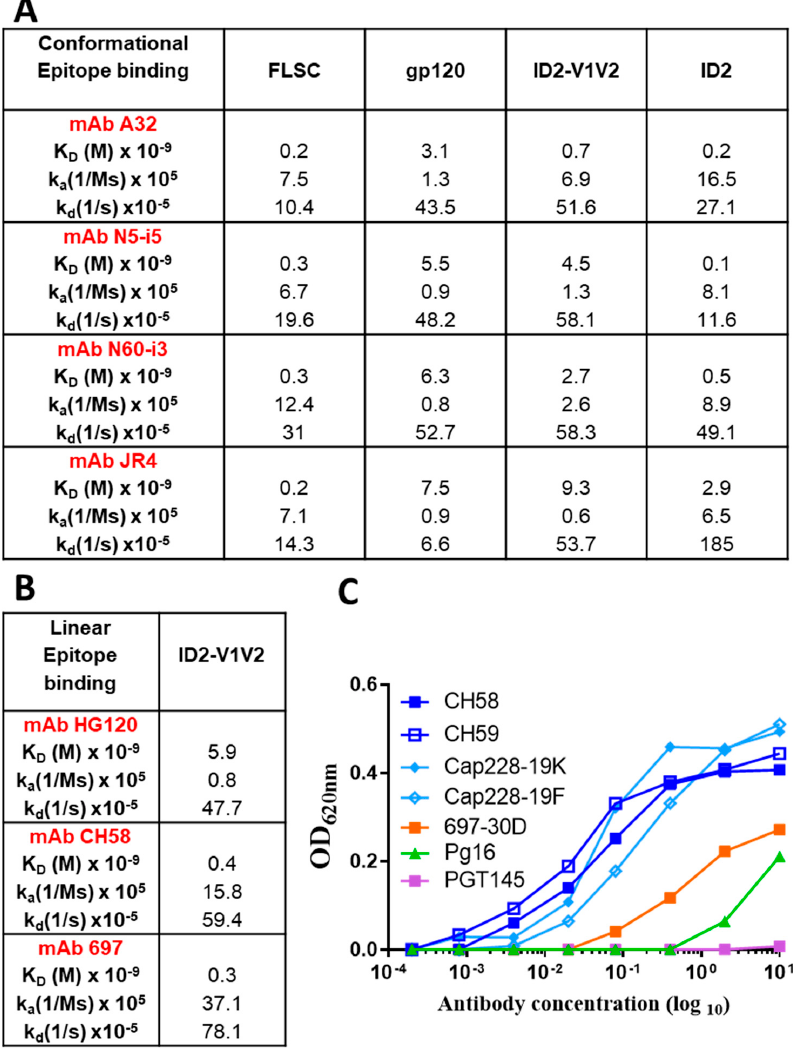
Figure 2. Characterization of ID2-V1V2. ( A ) Binding kinetics of conformational Cluster A Abs to the FLSC, gp120 and ID2-V1V2 by SPR. ( B ) Binding kinetics of linear V2 Abs to ID2-V1V2 by SPR. Abs were captured onto A Protein A CM5 sensor chip and antigens passed over at 0–200 nM concentrations. The binding kinetics (association rates (ka), dissociation rates (kd) and affinity constants (Kd)) were calculated with the BIAevaluation software. ( C ) ELISA showing binding of multiple V2-specific antibodies to 50 ng per well adsorbed ID2-V1V2 over a range of Ab concentrations from 10 µg to 0.00012 µg. 3.2. ID2, ID2-V1V2 Mix Elicits More Antigen-Specific Antibodies than ID2 Alone To investigate the immunogenicity of ID2-V1V2, we first immunized six BALB/c mice